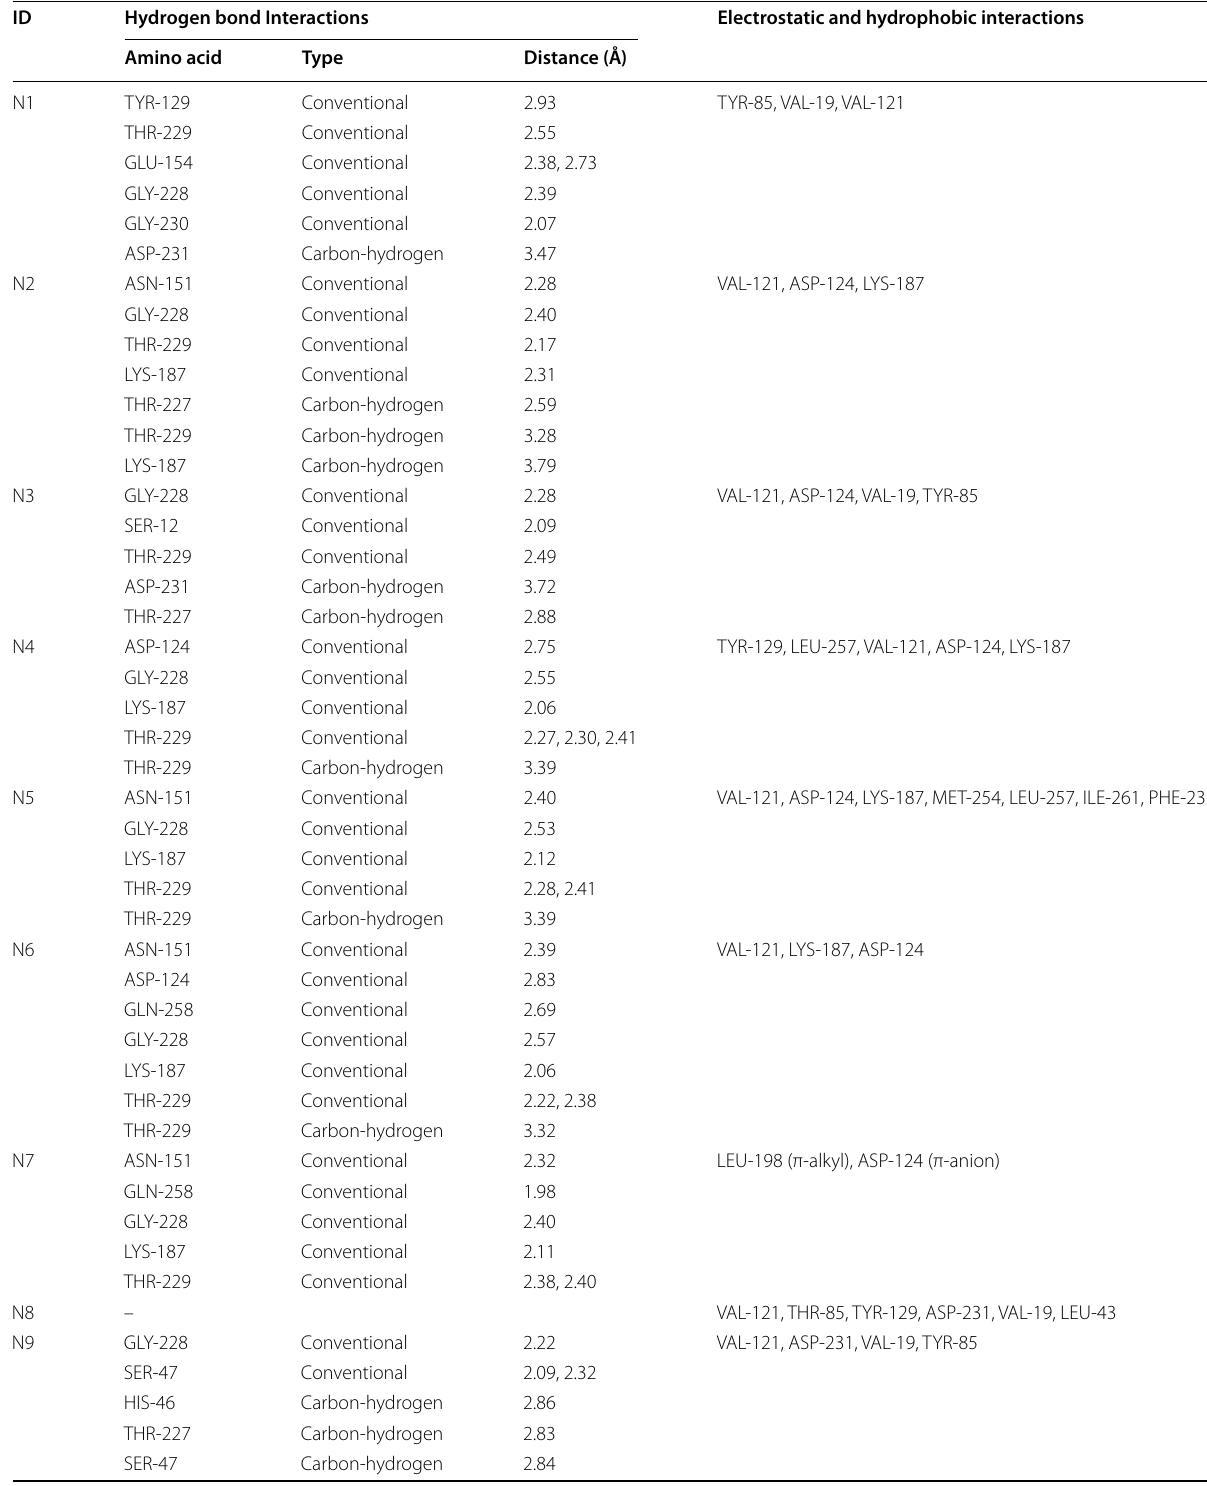
Table 12 Predicted binding interaction profile of newly designed molecules with PdxK receptor ID Hydrogen bond Interactions Electrostatic and hydrophobic